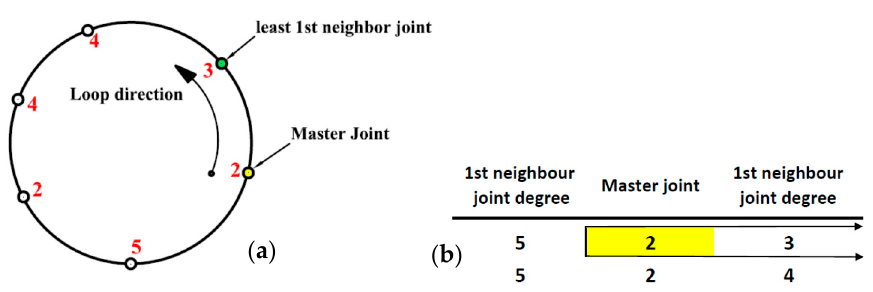
Figure 4. Generation of ULA. ( a ) loop with two master joints with distinct 1st-neighbor joint degrees. ( b ) Comparison between master joint neighbors.